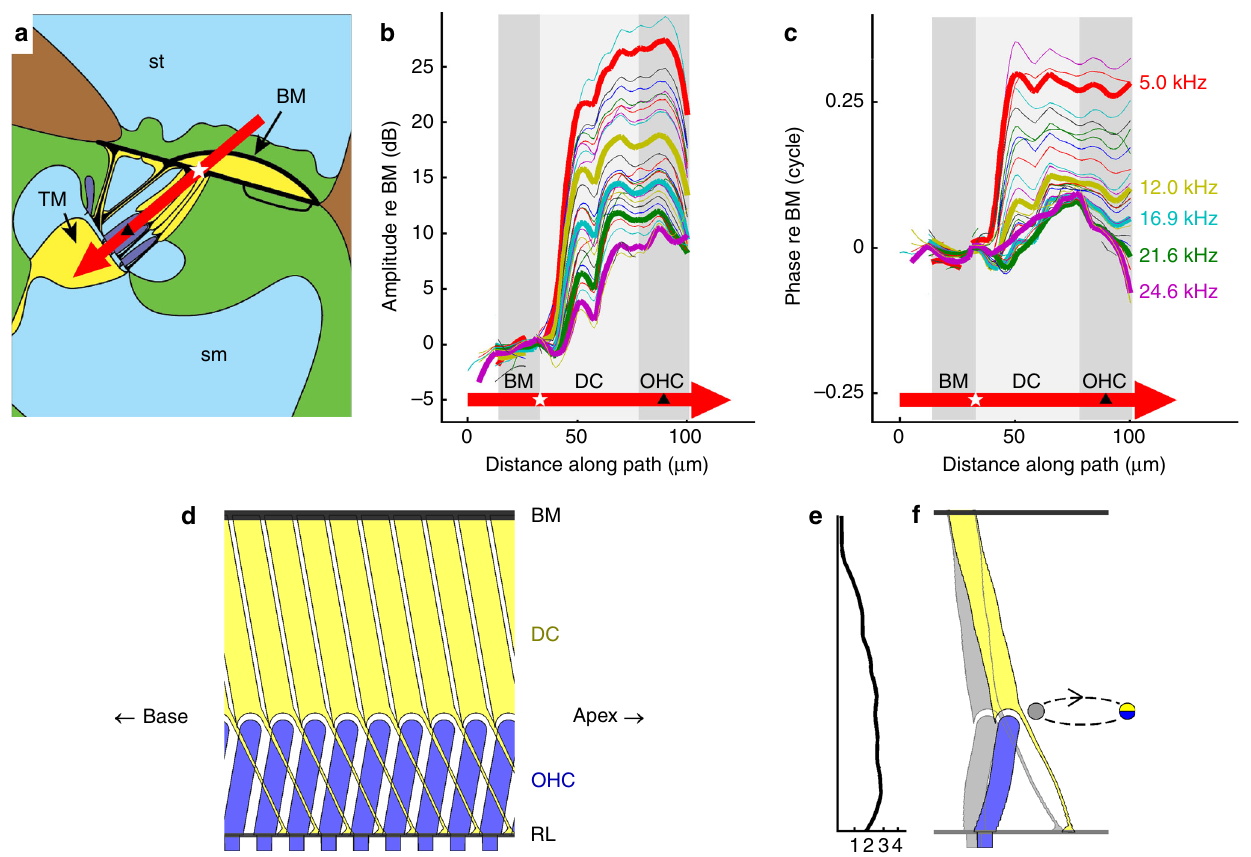
Fig. 7 Frequency-dependent spatial pro fi les of a vibration hotspot. a Transverse anatomical schematic for the 23 kHz region of the gerbil cochlea (cf. Fig. 2a), illustrating the spatial pathway (red arrow) across which vibration amplitude ( b ) and phase ( c ) were analyzed. The white star marks the reference point on the BM; the black triangle the middle of the outer hair cell region. b , c Spatial pro fi les of vibration amplitude and phase for 21 different frequency components (color-coded) in a multi-tone stimulus. The curves for fi ve frequencies (indicated in c ) are highlighted by increased line width. Amplitudes and phases are expressed relative to those observed on the BM (cf. white star in a ). Gray patches indicate the different regions traversed by the red arrow, including the BM, Deiters ’ cells (DC), and OHCs. d Schematized anatomical relationship between Deiters ’ cells (yellow) and OHCs (blue) along the longitudinal axis of the cochlea, perpendicular to the section shown in a . The cells are shown suspended between BM and RL, with the OHC stereocilia protruding downwards (beneath the level of the RL). The apical-ward projection of the Deiters ’ cells soma and phalangeal processes contrasts with the basal-ward projection of the OHC 43,51 . e Measured vibration pro fi le for the 5-kHz data of b , recast onto linear coordinates, for comparison with the cartoon in f . f A hypothetical interpretation of the pro fi le from e , based on the idea that motion in the OHC/Deiters ’ cell hotspot is primarily oriented in the longitudinal direction (see text). Two snapshots of a single OHC/Deiters ’ cell “ unit ” are shown, one in gray and the other in colors (blue, OHC; yellow, DC). The snapshots depict the unit at the two extremes of an elliptical vibration cycle. The illustrated movement is highly exaggerated: the measured 2.8-nm maximum displacement is scaled up 1000-fold, relative to the scale of the cellular anatomy, to make it visible in the illustration. Data were obtained from the same preparation as in Figs. 2, 3, CF 23 kHz. Stimulus level 50 dB